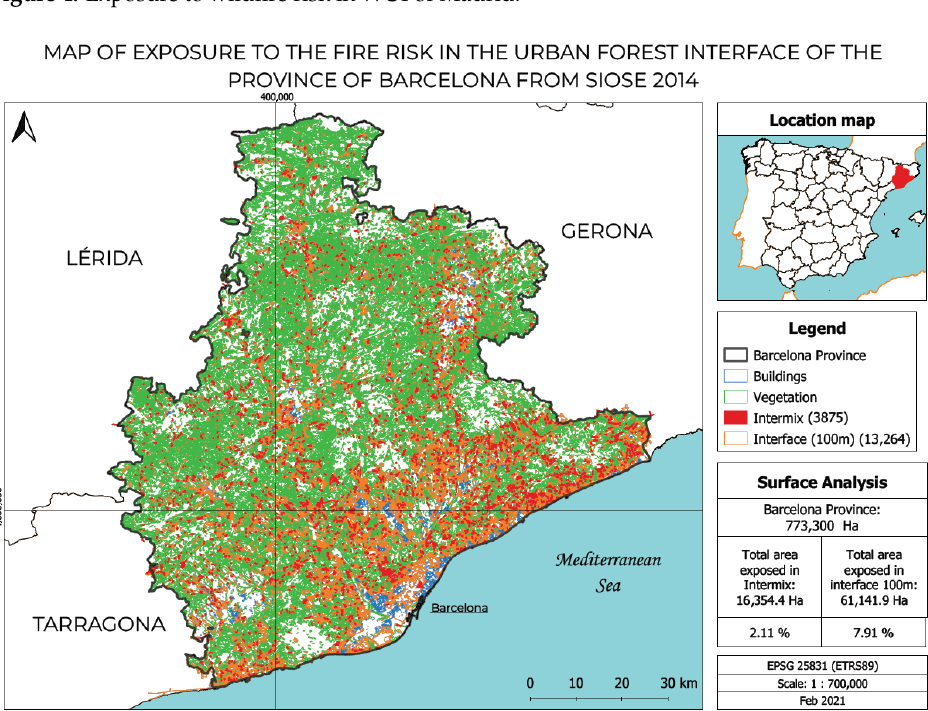
Figure 5. Exposure to wildfire risk in WUI of Barcelona. The areas exposed to fire risk in the province of Madrid represent a little less than 1% in an intermix situation and almost 2% of the territory in an interface situation according to the results obtained from SIOSE, whereas in Barcelona, they represent a little more than 2% in an intermix situation and almost 8% of the territory in an interface situation. The areas are represented at a larger scale in order to evaluate the degree of detail achieved. In Madrid, the study was conducted in the municipalities of El Escorial, Galapagar and San Lorenzo del Escorial, and in Barcelona, in the Garraf region, with the aim of